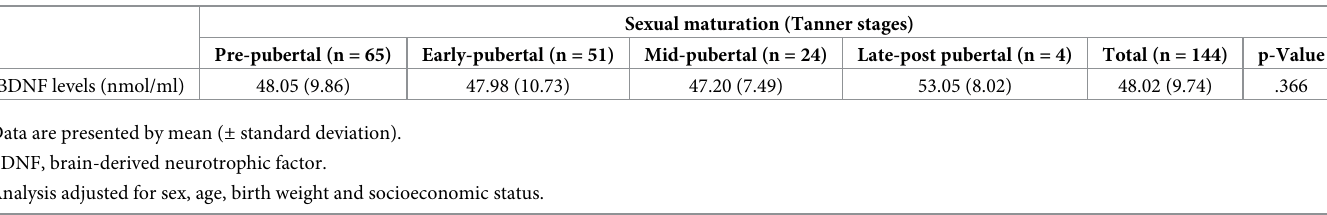
Table 4. Mean difference in BDNF levels by sexual maturation